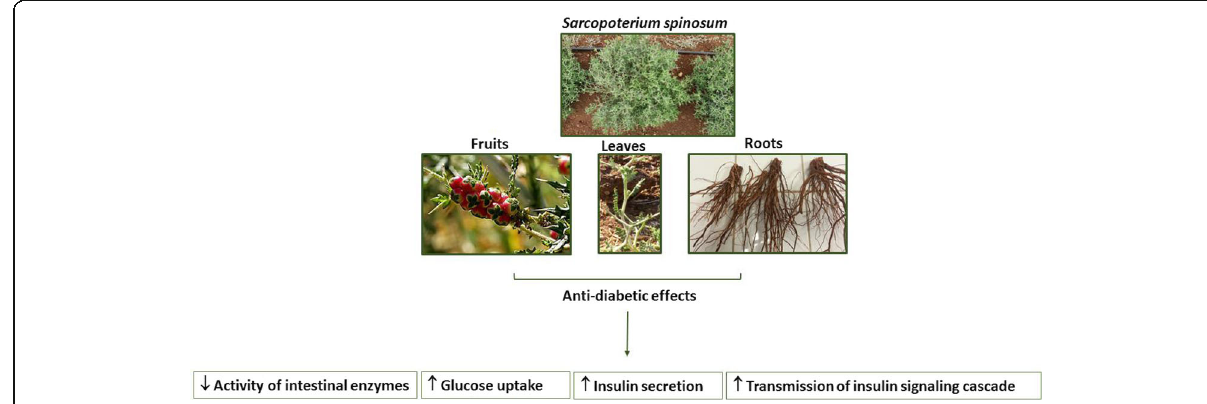
Fig. 9 A schematic diagram of antidiabetic properties of extracts of various S. spinosum